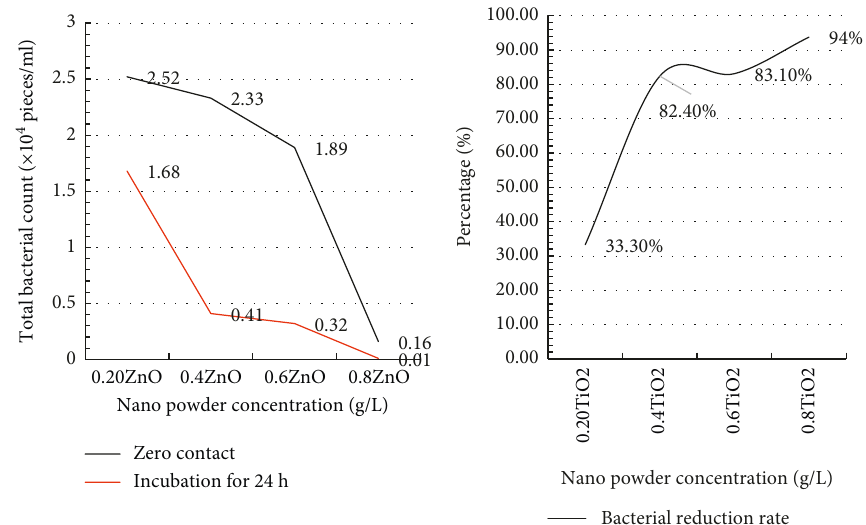
Figure 10: Evaluation of ZnO antibacterial